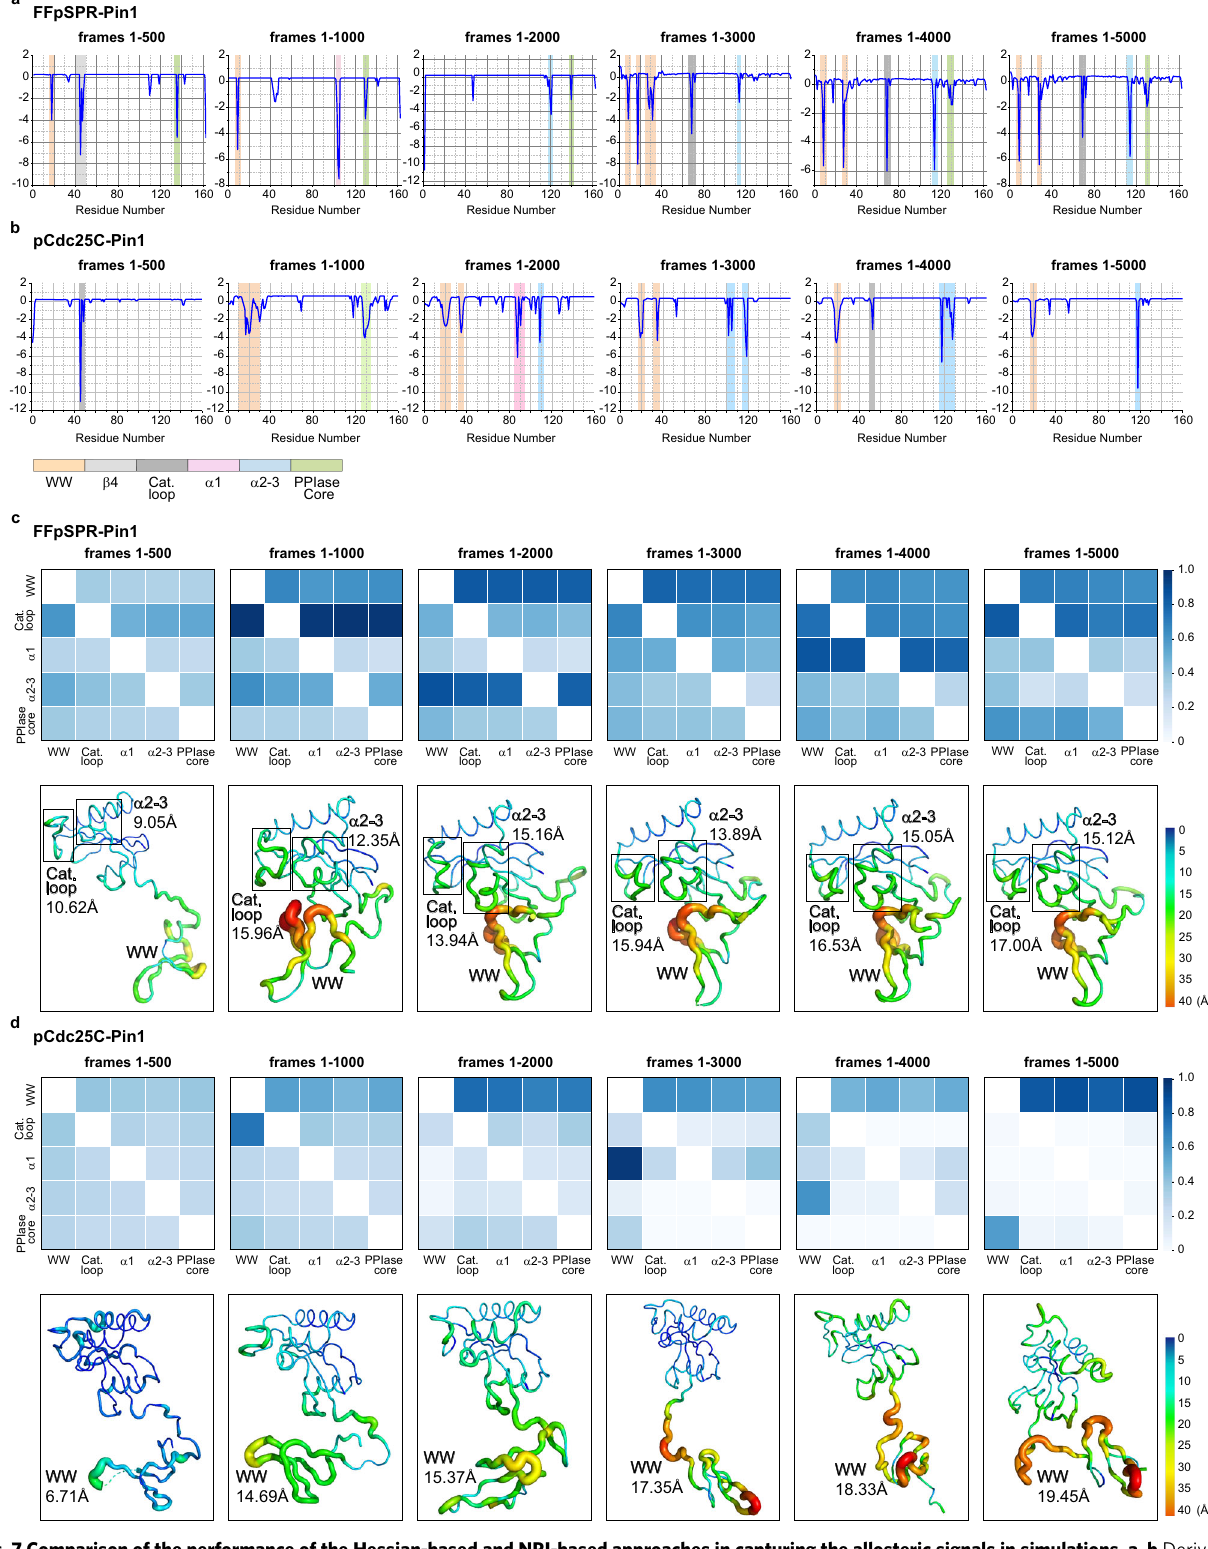
Fig. 7 Comparison of the performance of the Hessian-based and NRI-based approaches in capturing the allosteric signals in simulations. a , b Derivative node metrics δ node based on Hessian as a function of residues for FFpSPR- and pCdc25C-bound Pin1 systems. The metrics are calculated using frames 1 – 500, 1 – 1000, … , 1 – 5000 of the trajectories. Residues that have strong connections are highlighted by vertical bars, whose colors depend on the domains. c , d Distribution of learned edges between the domains and the corresponding average conformation mapped with RMSD values for FFpSPR- and pCdc25C-bound Pin1 system. The edges are learned from frames 1 – 500, 1 – 1000, … , 1 – 5000 of the trajectories. The domains presented here are WW domain (WW), catalytic loop (Cat. loop), α 1-helix ( α 1), α 2-3 helices ( α 2-3), and PPIase